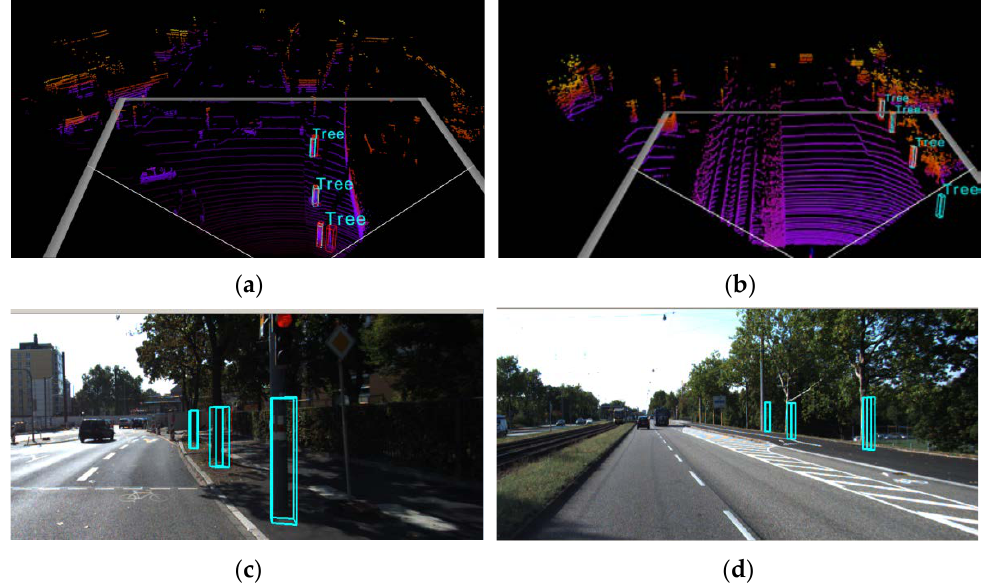
Figure 10. Test results of PointRCNN. ( a ) Three-dimensional view of the ( c ); ( b ) Three-dimensional view of the ( d ); ( c ) camera image; ( d ) camera image.